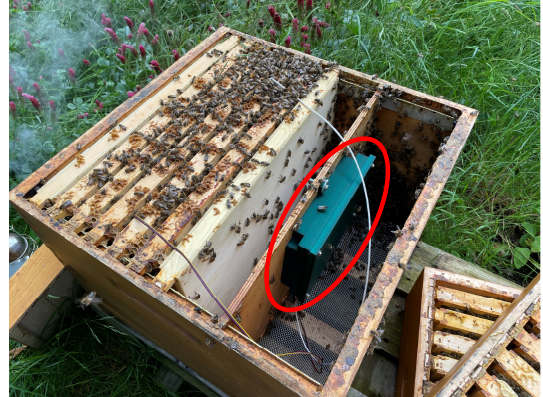
Figure 1. The prototype bee hive microclimate sensor (green-colored